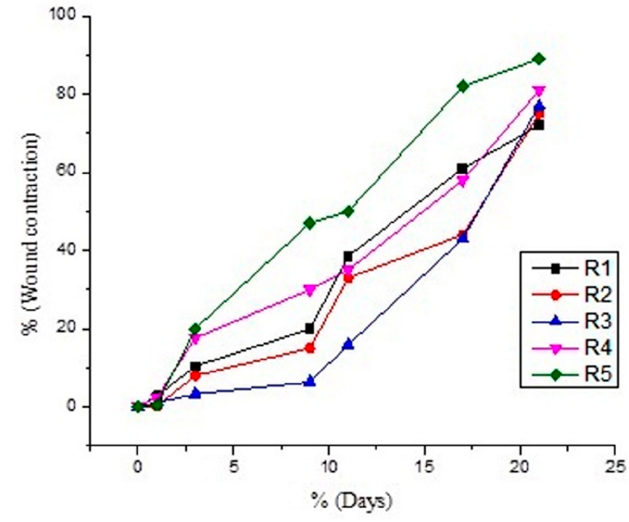
Gels 2022 , 8 , x FOR PEER REVIEW Figure 6. Graph between wound contraction rate and time. Figure 6. Graph between wound contraction rate and time.